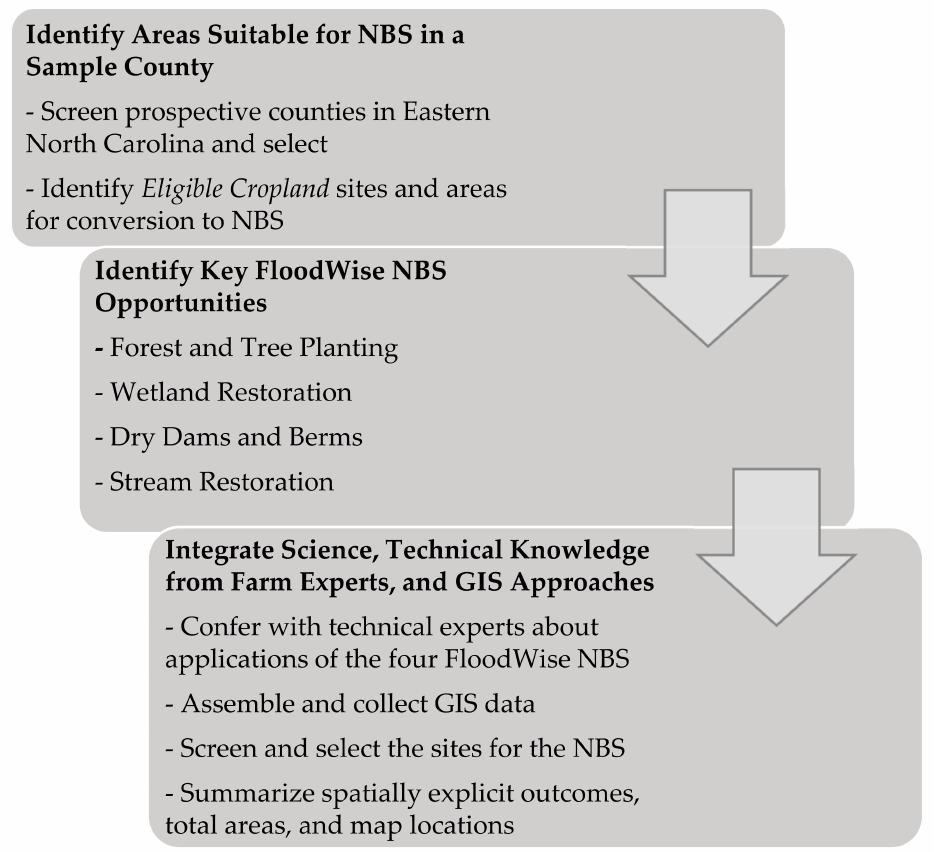
Figure 3. Summary of Geospatial Analysis and NBS Suitability